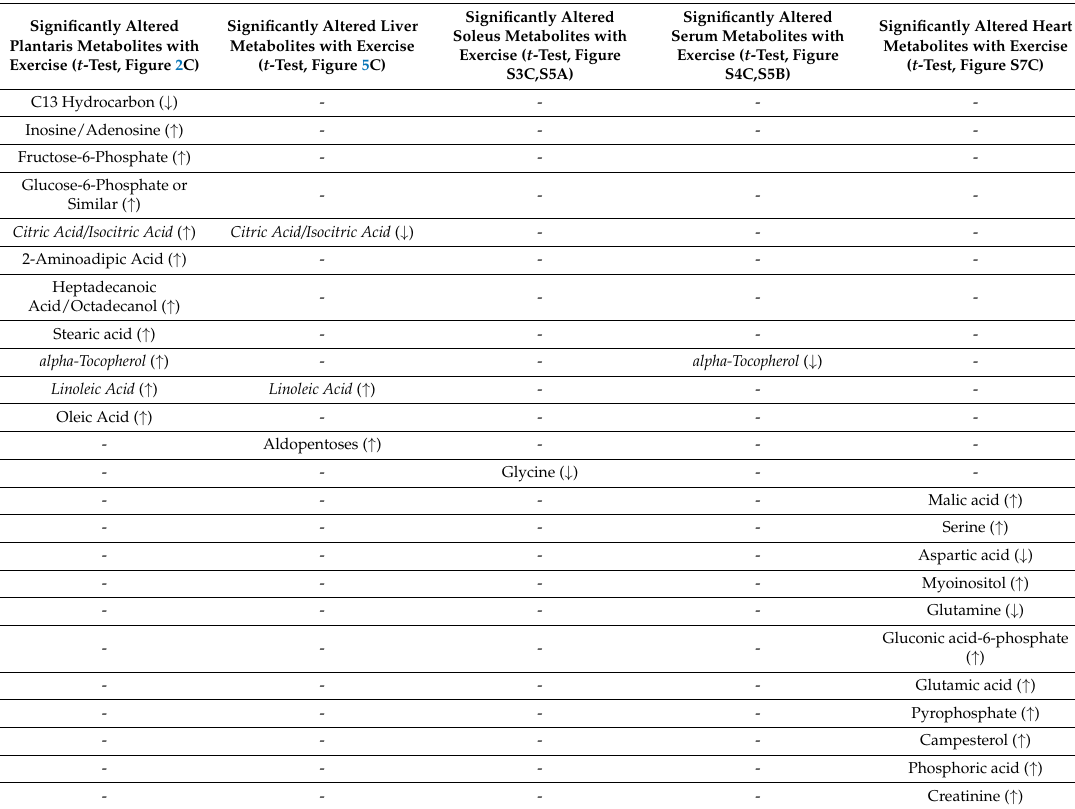
Table 2. Summary of t -test significantly altered metabolites across skeletal muscle, liver, serum, and heart in exercise trained animals compared to sedentary. Increased ( ↑ ) Decreased ( ↓ ). Italics: metabolite found in more than one tissue